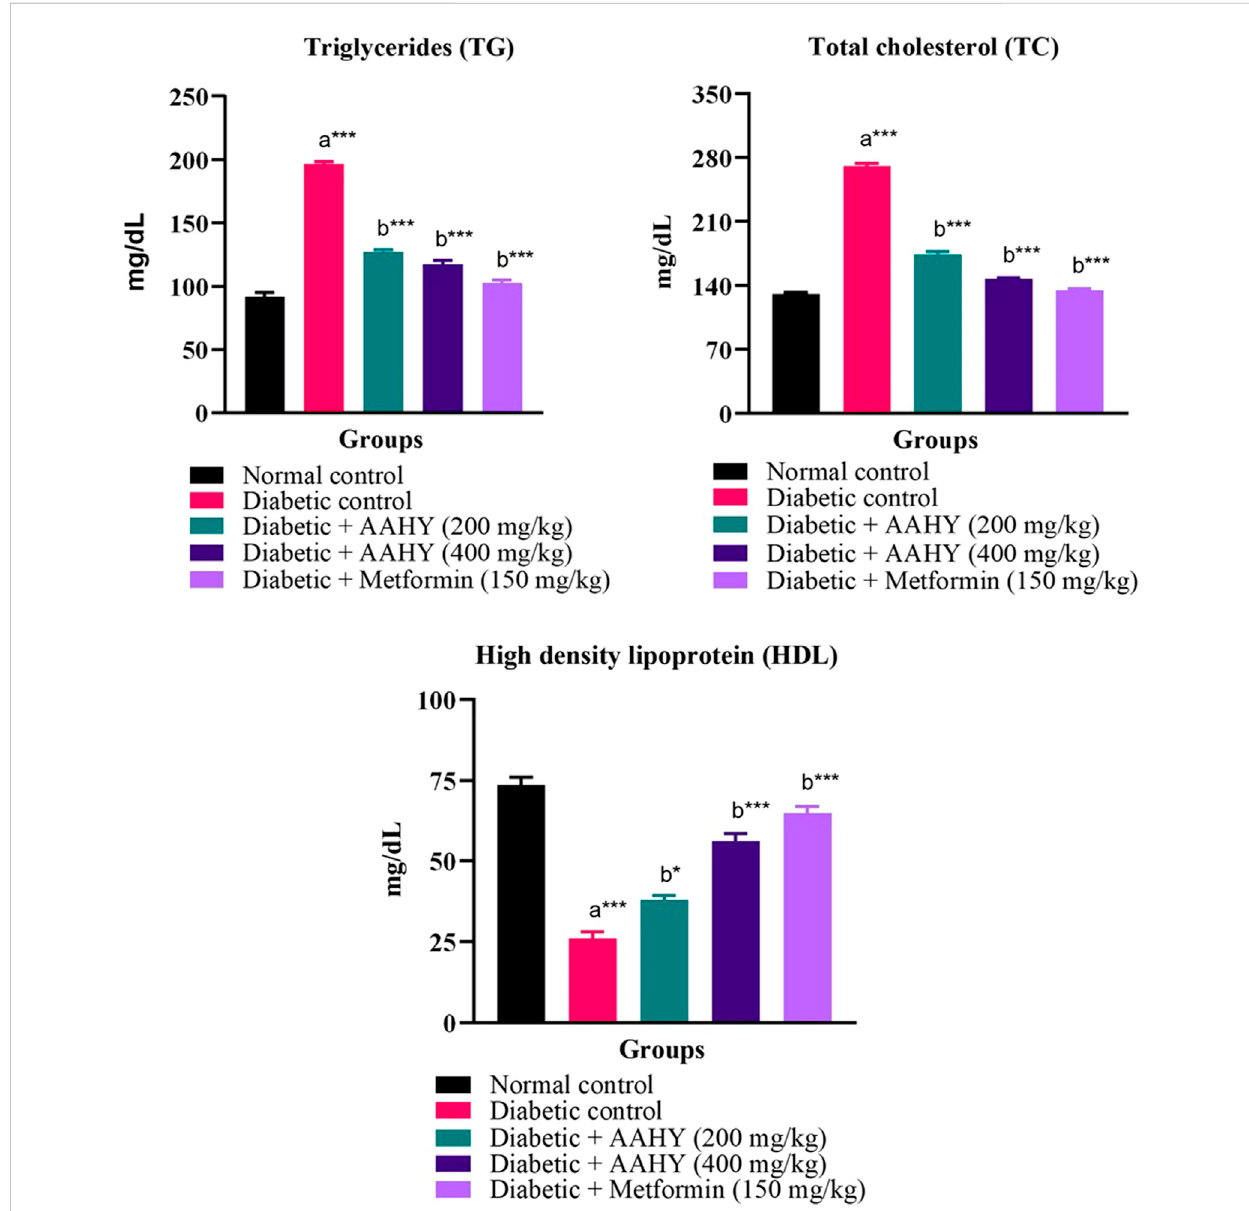
FIGURE 6 Effect of the AAHY extract on the serum lipid pro fi le. The error bar denotes mean ± SEM and n = 6 for each group. a represents the diabetic control group versus the normal control group, and b represents the diabetic control group versus treated groups. * p < 0.05, ** p < 0.01, and *** p < 0.001. SEM: standard error of